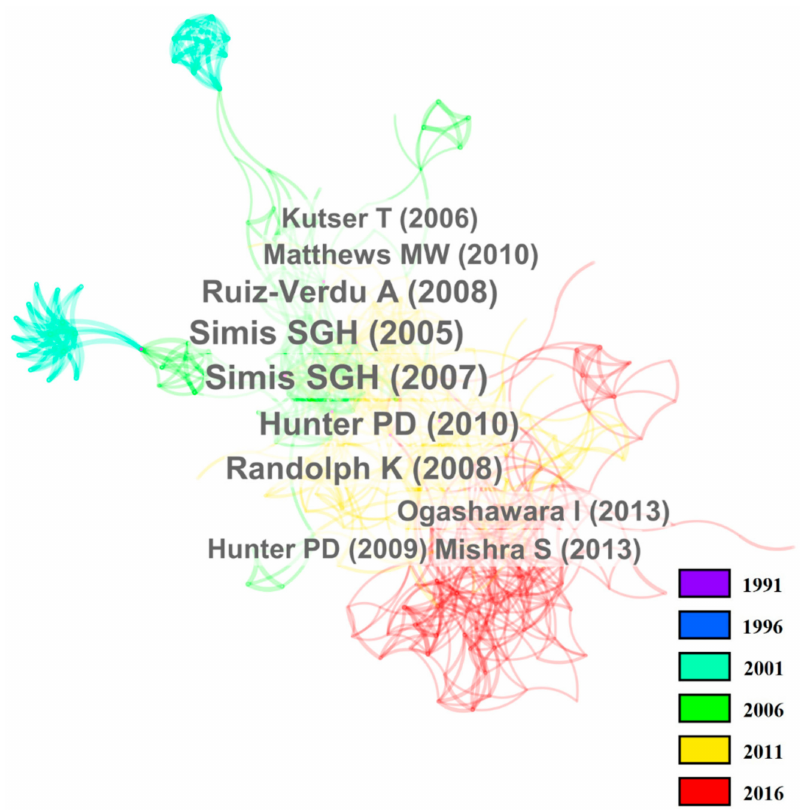
Figure 2. The co-citation network of remote sensing of PC and the most cited